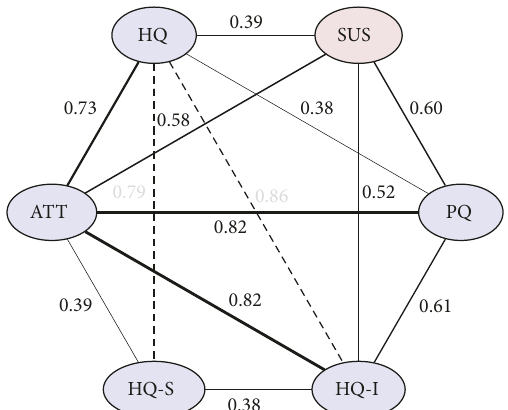
Figure10:PearsoncorrelationcoefficientsfortheAttrakDiff-2(blue)andSUS(red)questionnaireresults,basedontheacquiredquestionnaire data. The line thickness is proportionate to correlation strength of the different aspects of quality measured.